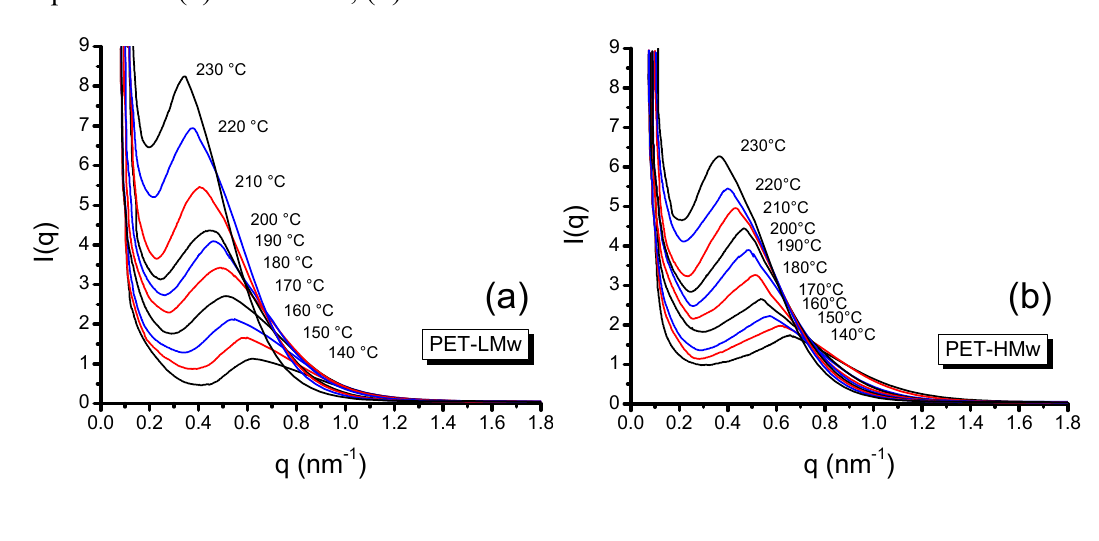
Figure 9. SAXS patterns of isothermally crystallized (30 min) PET at different temperatures: ( a ) PET-LMw; ( b )